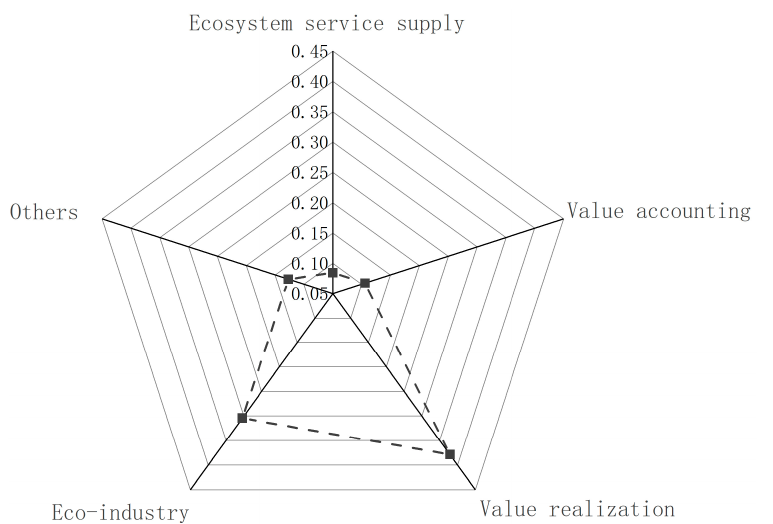
Figure 3. The literature classified by ecosystem service supply, value accounting, value realization, eco-industry, etc.